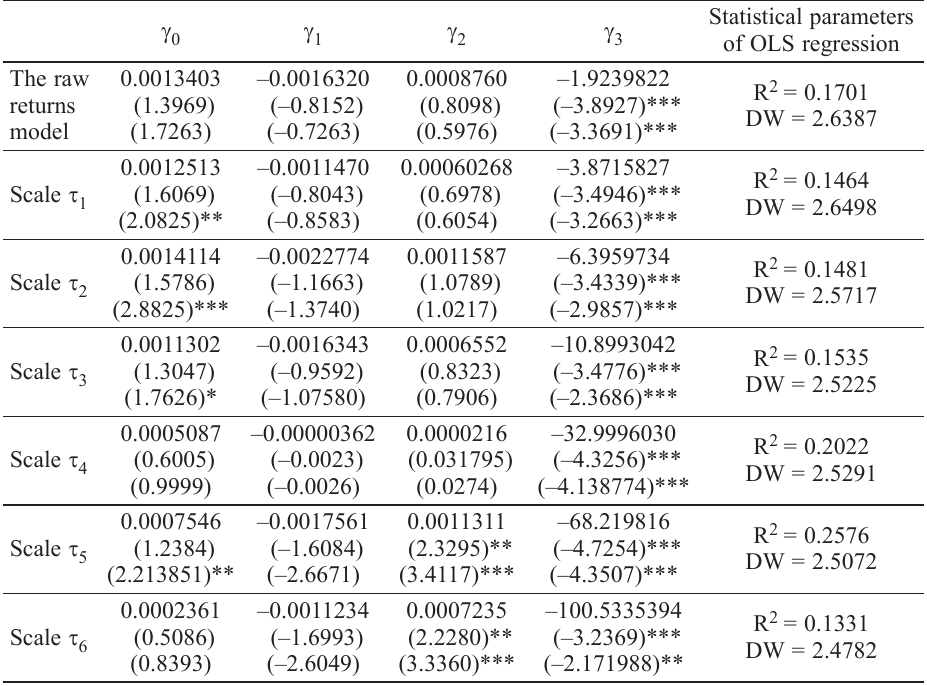
Table 6. OLS and GMM results of testing the CAPM implications for the Czech stock